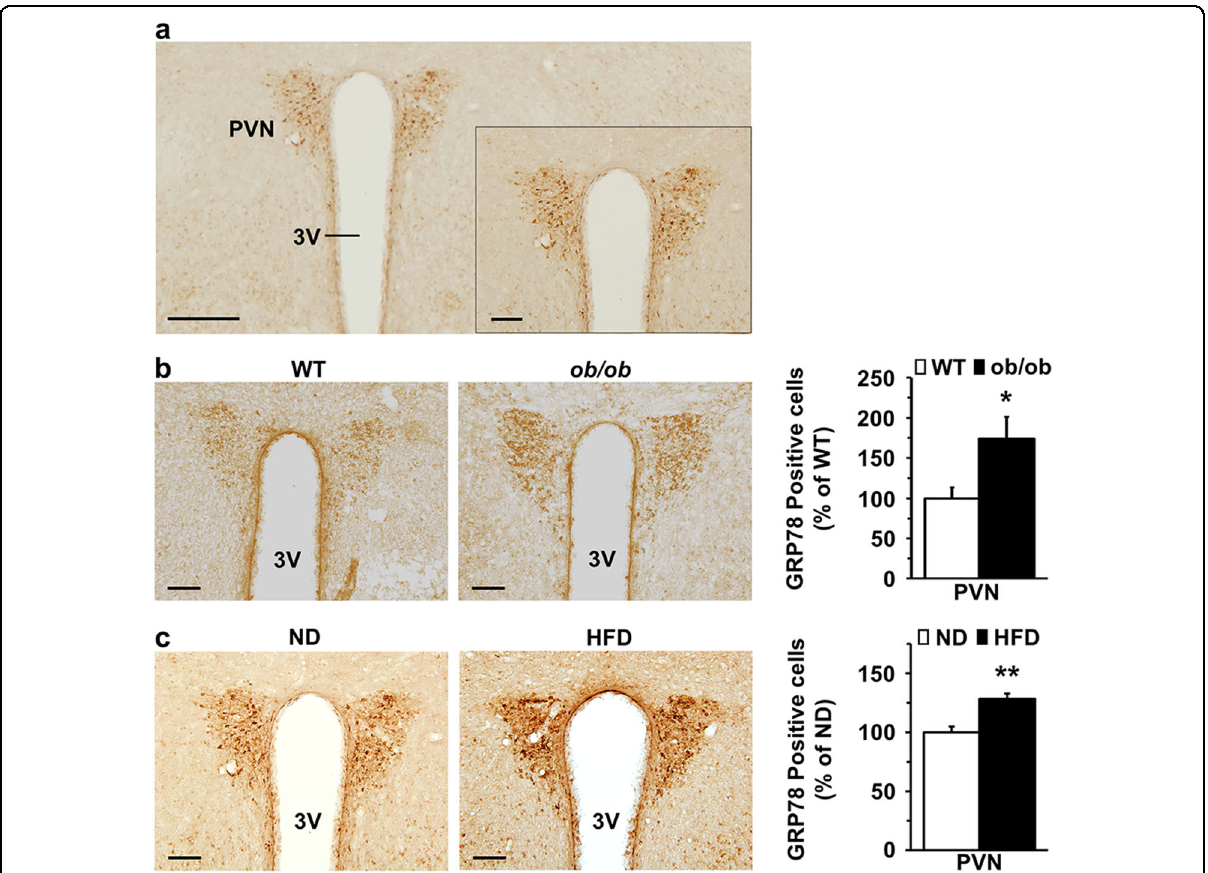
Fig. 3 GRP78 expression in the PVN of ob/ob and diet-induced obese mice. Sections were prepared from the obese mouse models: 10 – 12- week-old ob/ob male mice and high-fat diet (HFD)-fed DIO mice. WT and normal diet (ND)-fed male mice were used as controls. Representative coronal sections (40 µm) stained with an antibody against GRP78 and visualized by 3,3 ʹ -diaminobenzidine reactions are shown. a GRP78 expression in the hypothalamic PVN region. The inset in the panel shows the high-magni fi cation area of the PVN within the low-magni fi cation image (scale bar: low: 250 µm, high: 100 µm). b Representative images of GRP78 staining of sections from the PVN of ob/ob and WT mice (scale bar, 100 µm). c Representative GRP78 staining images in the PVN region of DIO mice (HFD) and control mice (ND) (scale bar, 100 µm). The number of GRP78- positive cells in the PVN was counted using stereological analysis, and the graph shows the percentage of the average total number of neurons/ nucleus/WT or ND mice. One-tailed Student ’ s t test for b : n = 4 per group, * P < 0.05 versus WT mice; One-tailed Student ’ s t test for c : n = 4 – 5 per group, ** P < 0.01 versus ND-fed mice. The data are presented as the mean ±